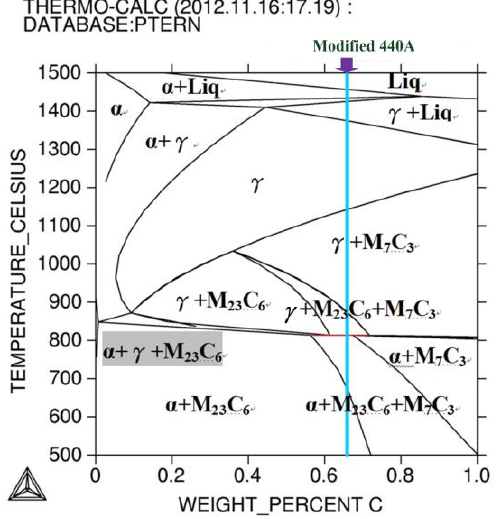
Figure 1. Phase diagram of the test sample calculated using Thermo-Calc.